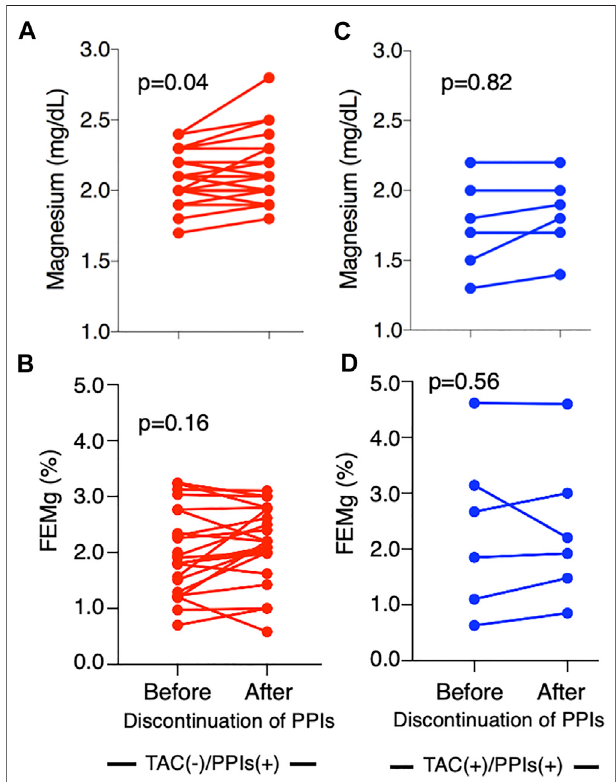
FIGURE3| Serialchangeinmagnesiumlevelafterthediscontinuationof proton pump inhibitors. Mg levels signi fi cantly increased after discontinuing PPI use in patients not using TAC ( p (cid:1) 0.04) (A) ; however, no signi fi cant differencewasseeninFEMg (B) .InpatientsusingTAC,nochangeinMg level or FEMg was observed after PPI discontinuation (C,D) . Mg, magnesium; PPI, proton pump inhibitor; TAC, tacrolimus; FEMg, fractional excretion of magnesium.